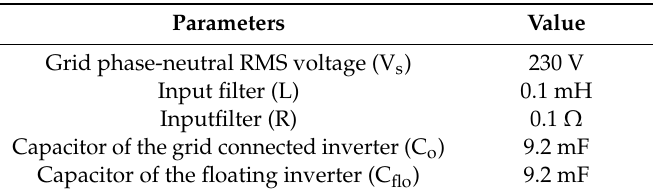
Table 6. Grid and Power Converters Data.